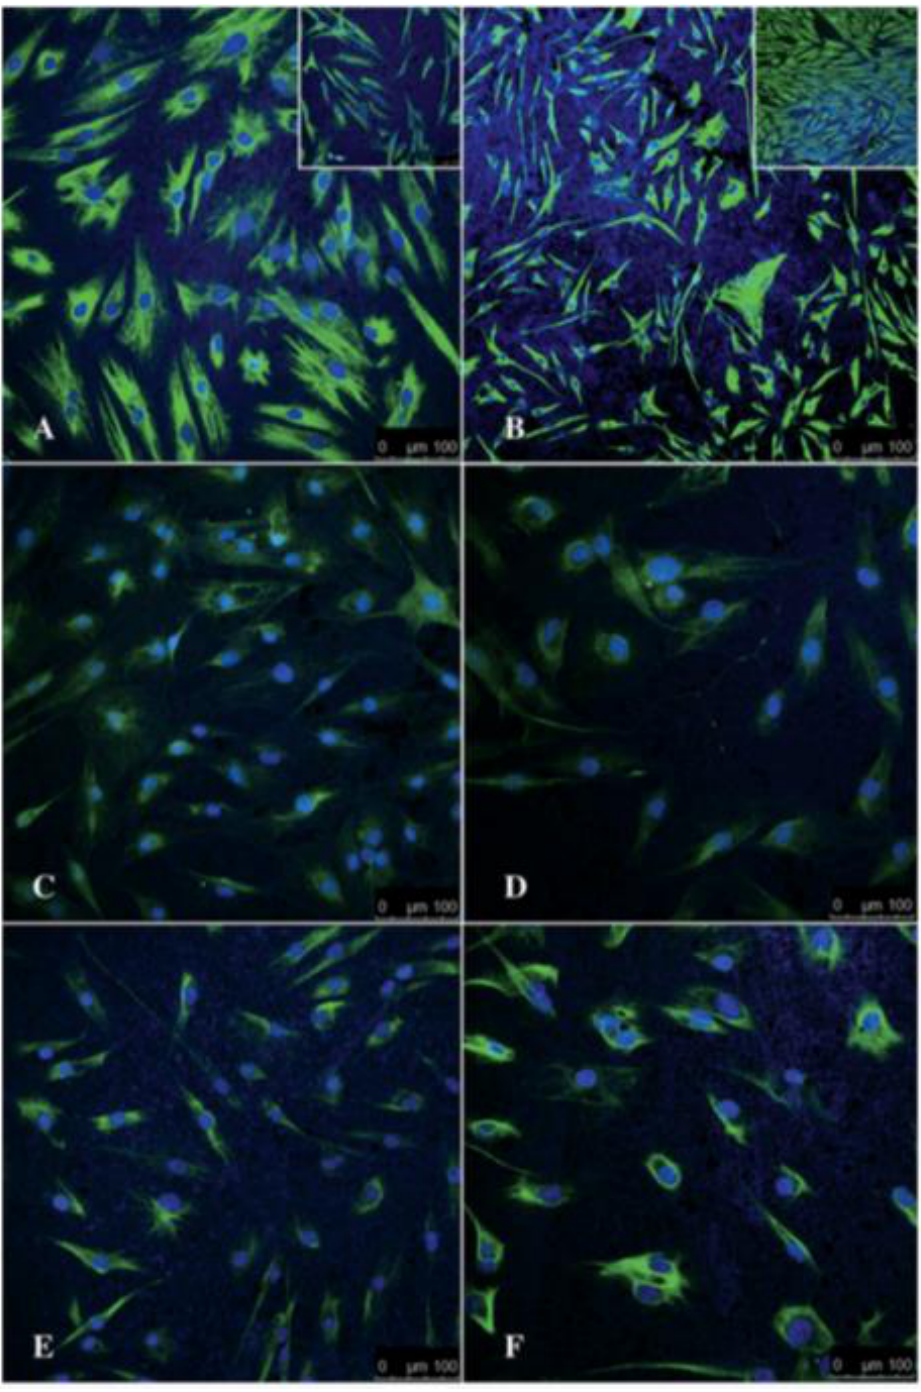
Figure 10. Representative 2D confocal microscopy images of hMSCs differentiating into cells of neural lineage on an AuNR substrate. Images show the expression of Vimentin, S100β, and GFAP at 24 h ( A , C , and E , respectively) and 6 days ( B , D , and F , respectively) after differentiation. The insets in A and B show the corresponding undifferentiated controls at 24 h and 6 days. Scale bar = 100 μm. Reproduced with permission from [9]. Springer Nature, 2014.